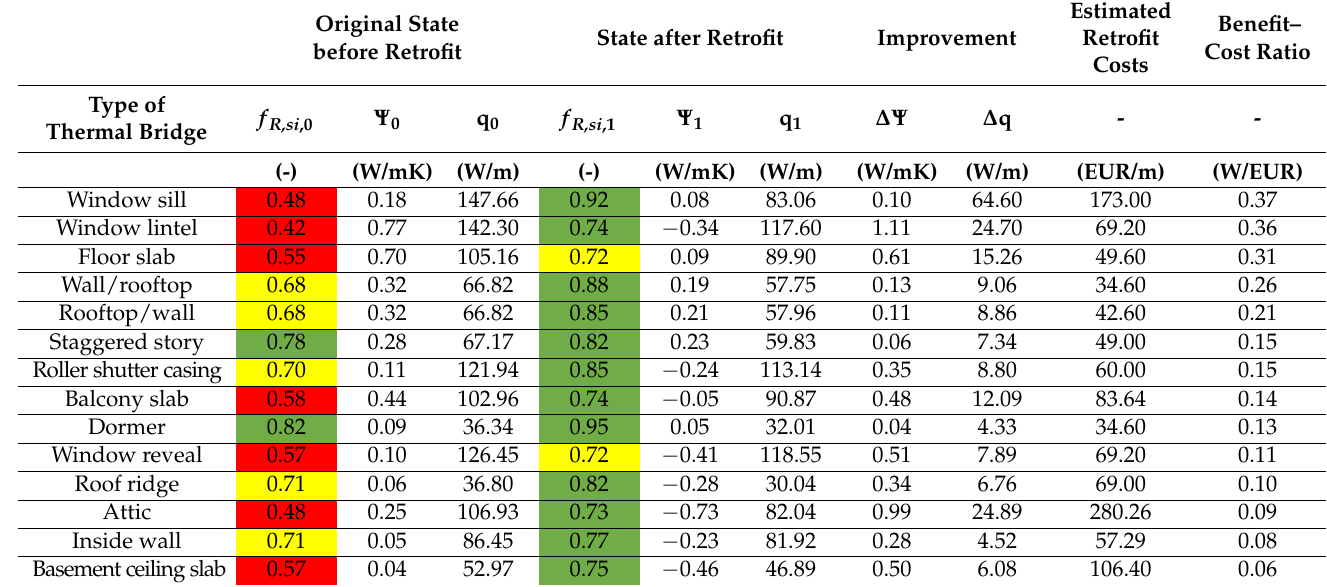
Table 3. Characteristic values, estimated costs, and benefit–cost ratios of the retrofits of 14 thermal bridge types in German buildings constructed between 1950 and 1969, prior to and after a retrofit (characteristic values are based on simulations with ThermCad, costs are based on BKI prices as of 2020 [38,39]), sorted according to benefit–cost ratio. The temperature factor is either below (red), near (yellow), or above (green) the mold formation threshold f R , si of 0.7. Estimated Benefit– Original State State after Retrofit Improvement Retrofit Cost before Retrofit Costs